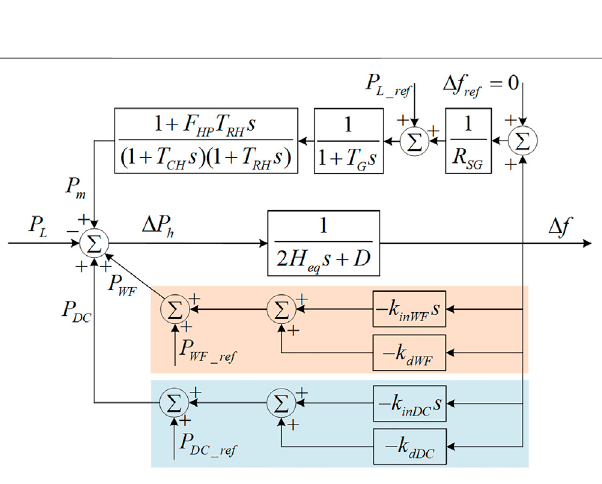
FIGURE 5 | Equivalent frequency response model of the power